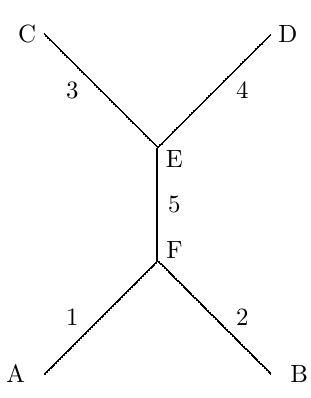
Figure 1 . A scattering process in